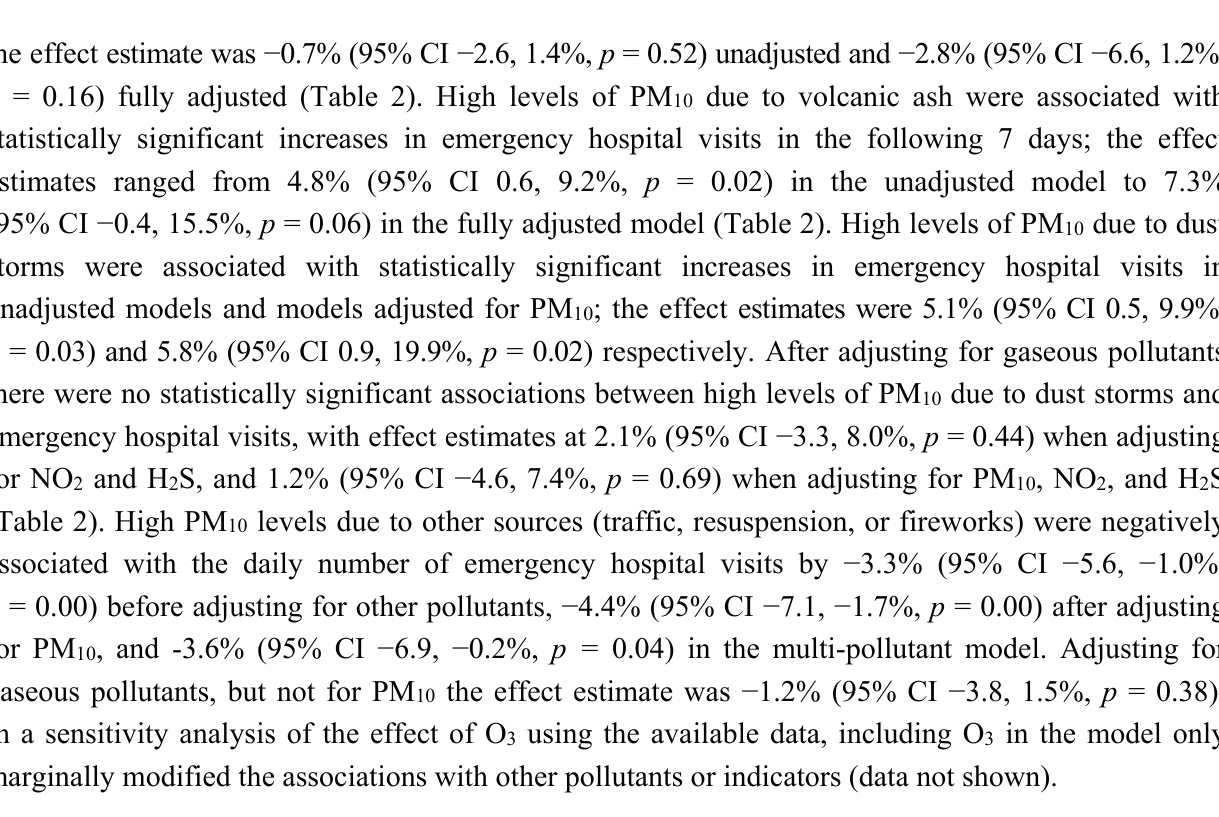
Table 2. Associations between daily emergency hospital visits for cardiorespiratory causes and one day of exposure to different sources of high PM 10 values at lag 0–7. All models are adjusted for time trend, annual variation, climate and influenza